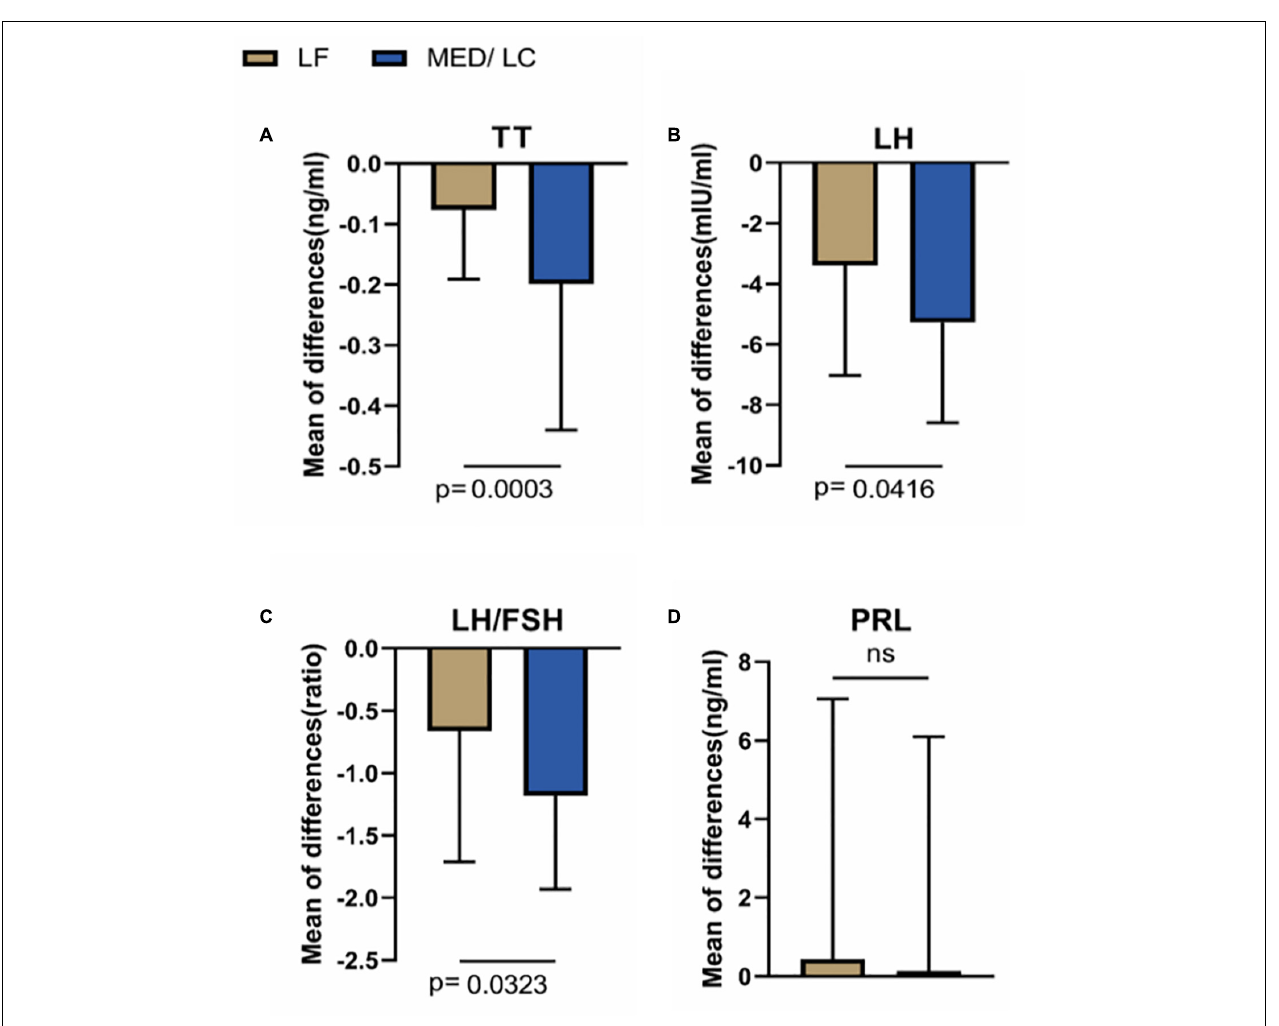
FIGURE 4 | Comparison of changes in serum sex hormone levels between two groups. (A) The MED/LC diet resulted in more total testosterone (TT) loss than the LF diet. (B) MED/LC diet reduced luteinizing hormone (LH) more than LF diet. (C) The MED/LC diet resulted in more ratio of luteinizing hormone to follicle-stimulating hormone (LH/FSH) loss than the LF diet. (D) Prolactin (PRL) changes of MED/LC diet and LF diet had no difference. Data are mean( ± SD). Analysis of variance with a covariance (ANCOVA) test was used.